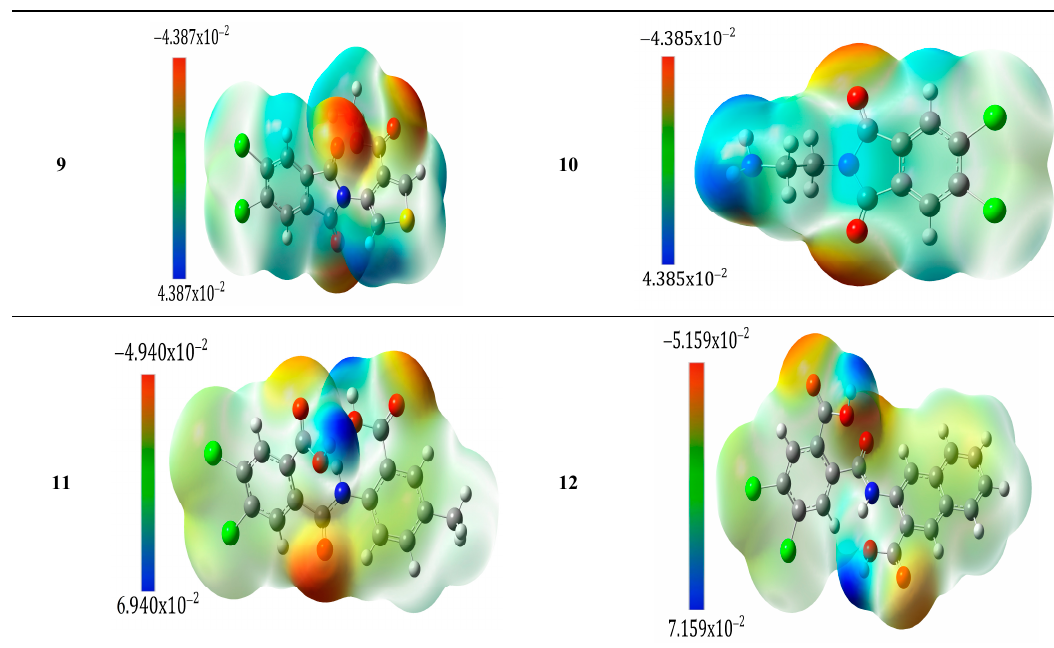
Figure 7. Molecular electrostatic potential of compounds 1 − 12.